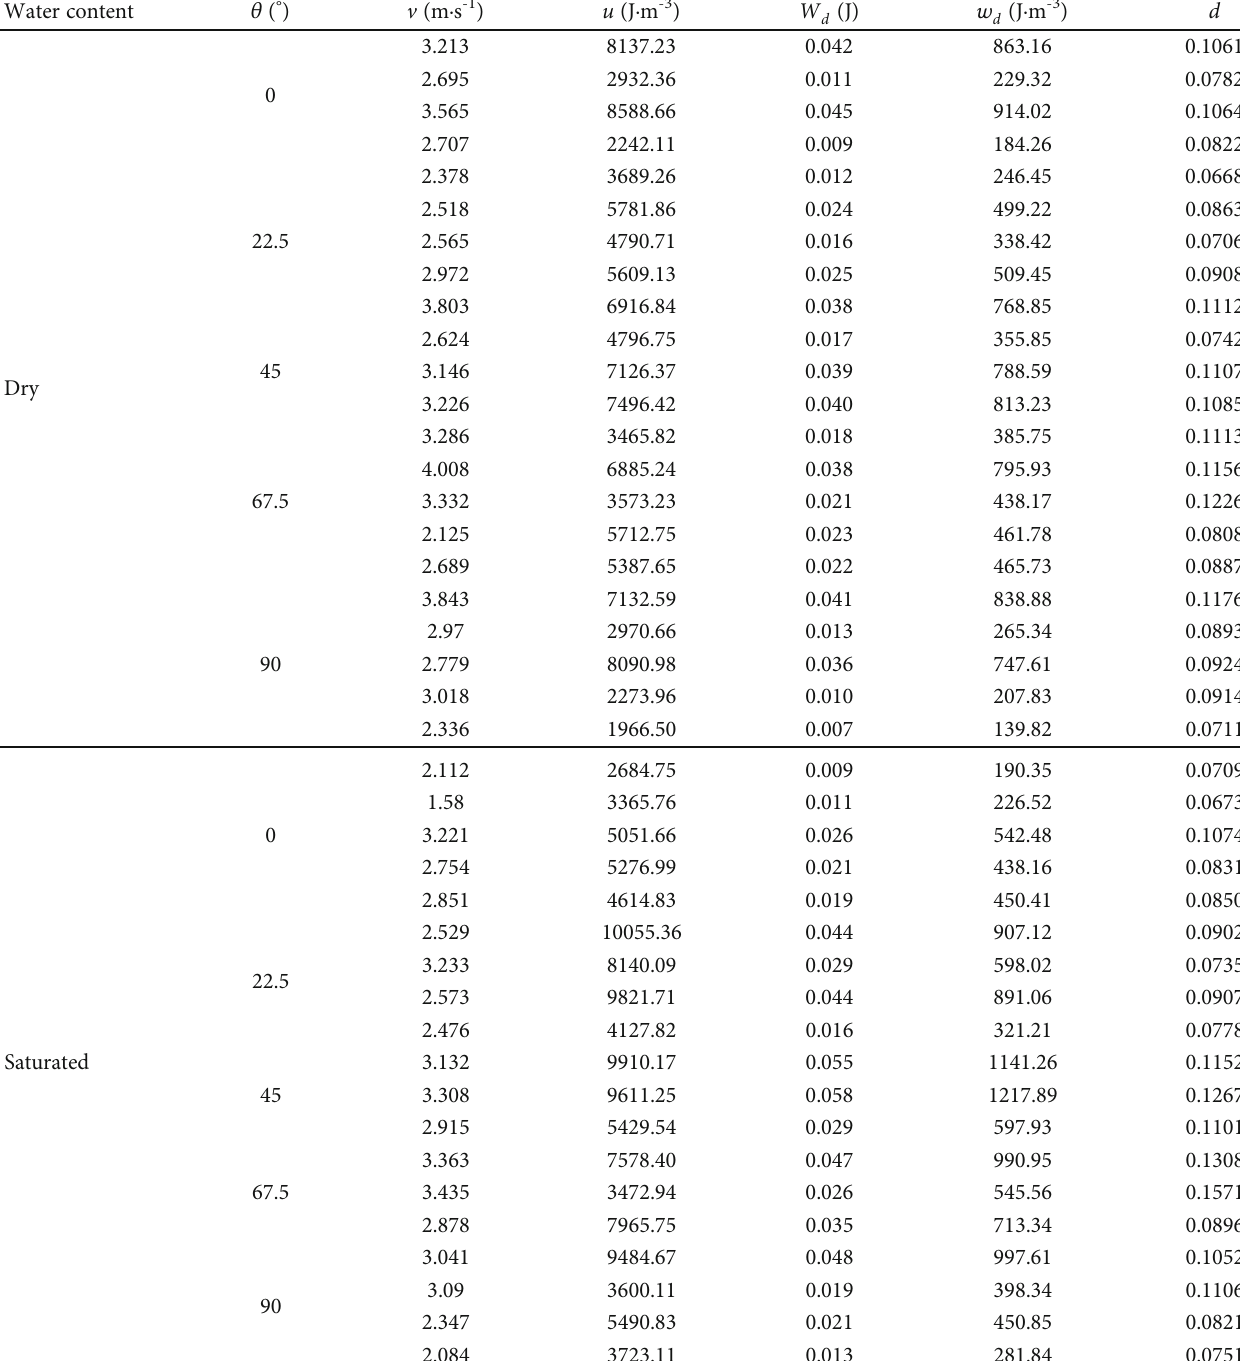
Table 3: Energy dissipation parameters of air-dry and water-saturated coal